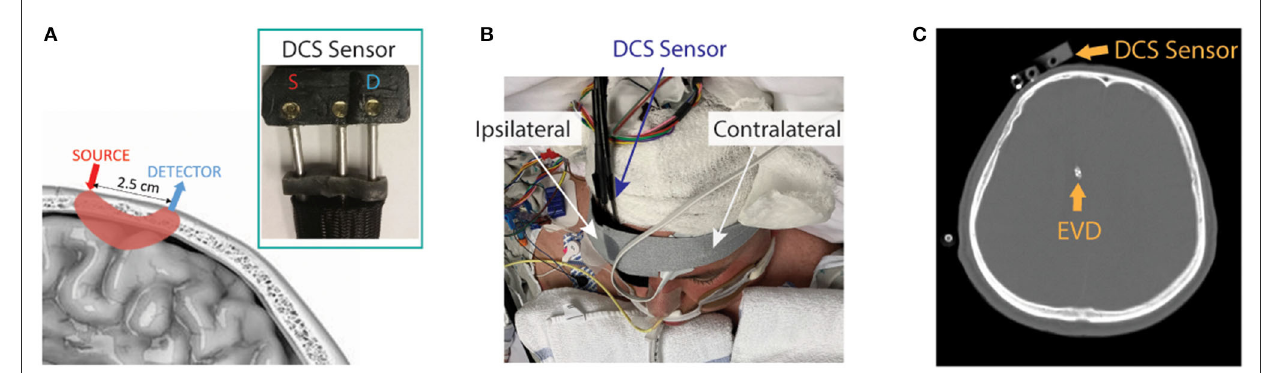
FIGURE1 Diffuse correlation spectroscopy (DCS) experimental setup. (A) Pictorial representation of the DCS sensor on the scalp and the optical interrogation path for the source and detector geometry (pink shaded region), along with a photograph of the sensor (inset). (B) The DCS sensor was secured to the patient’s forehead (patient image obtained with specific consent). (C) Representative CT scan showing typical placement of the DCS sensor and external ventricular drain